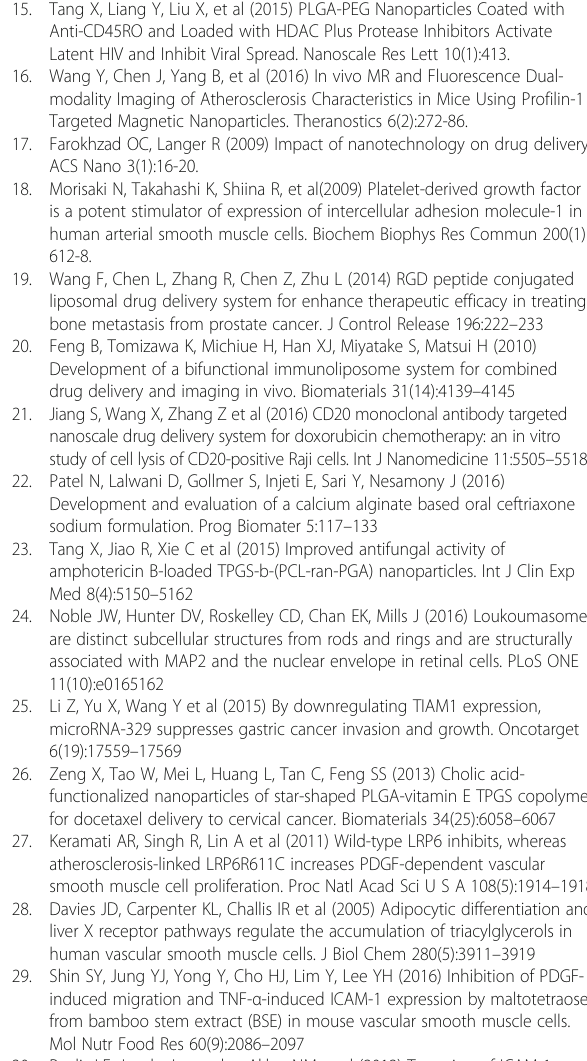
Additional file 3: Figure S3. The fluorescence spectra of the anti-ICAM-1- T0901317 liposomes were presented. The optimal absorption wavelength of liposomes is 518 nm. It can be seen that it is consistent with the fluorescent properties of the coumarin-6. (TIF 130